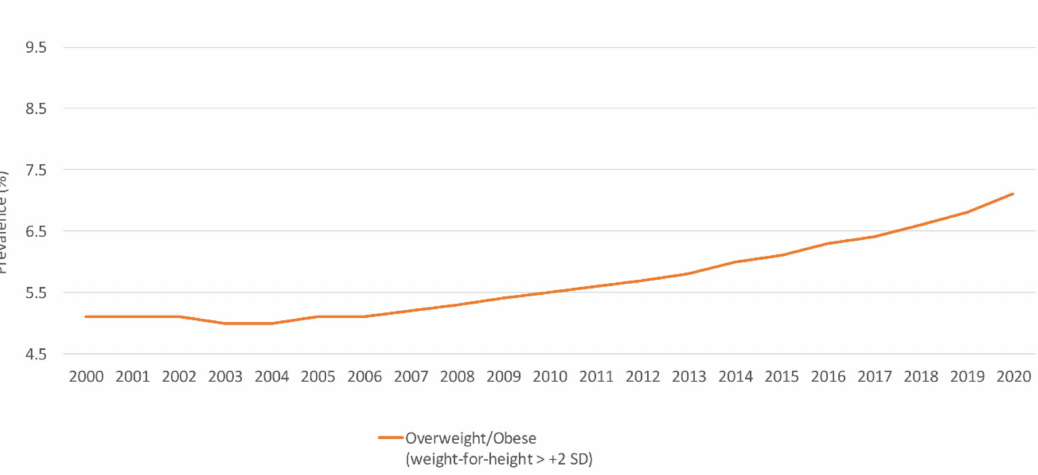
Figure 4. Trends in the prevalence (%) of overweight/obesity among children under 5 years in Jordan, modeled data (2000–2020). Abbreviations: SD: standard deviation. Source: WHO, 2021